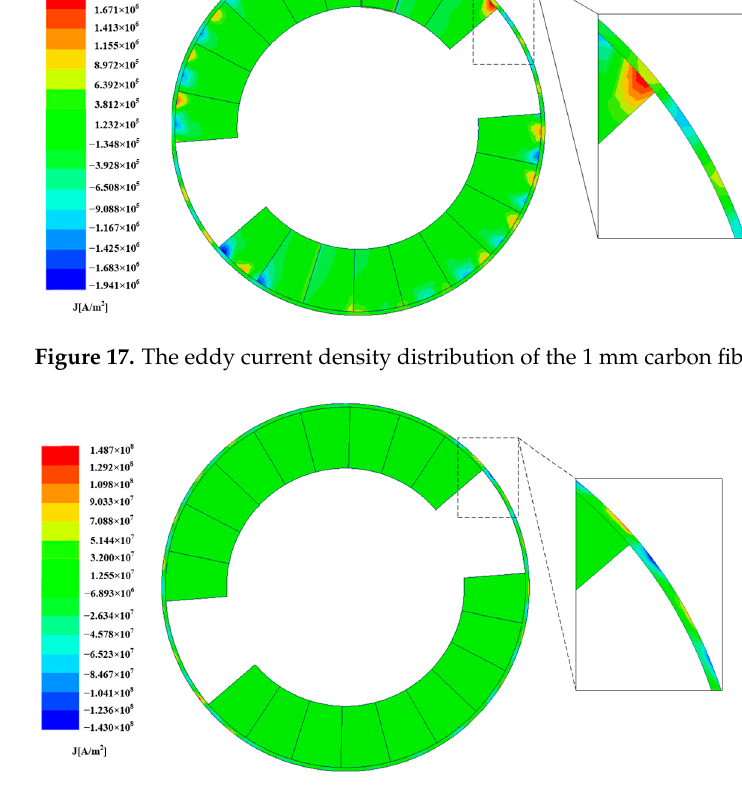
Figure 18. The eddy current density distribution of the 1 mm copper jacket.